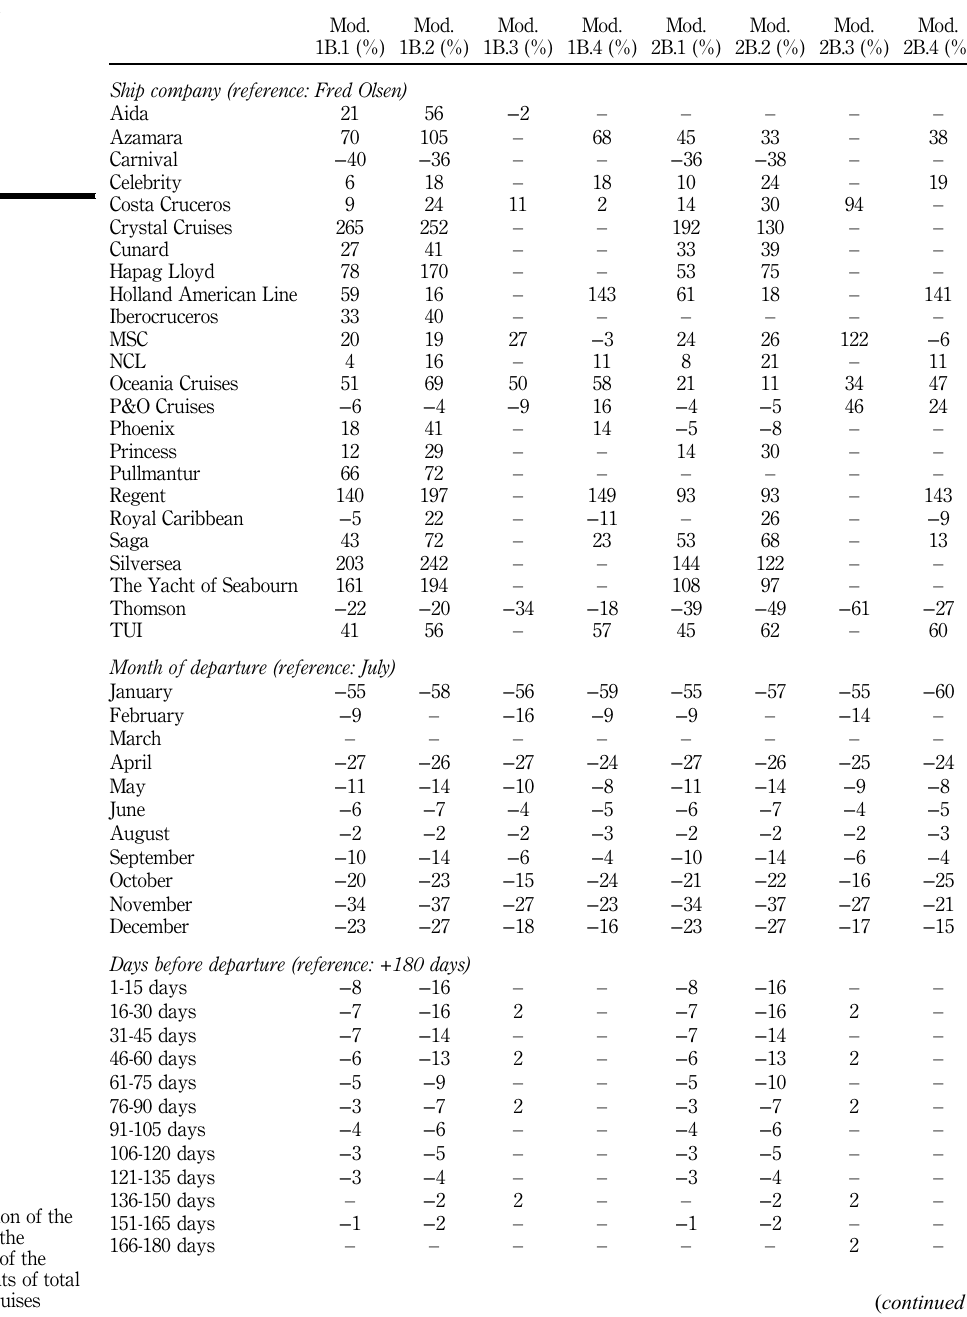
interpretation of the results for the regression of the determinants of total price for